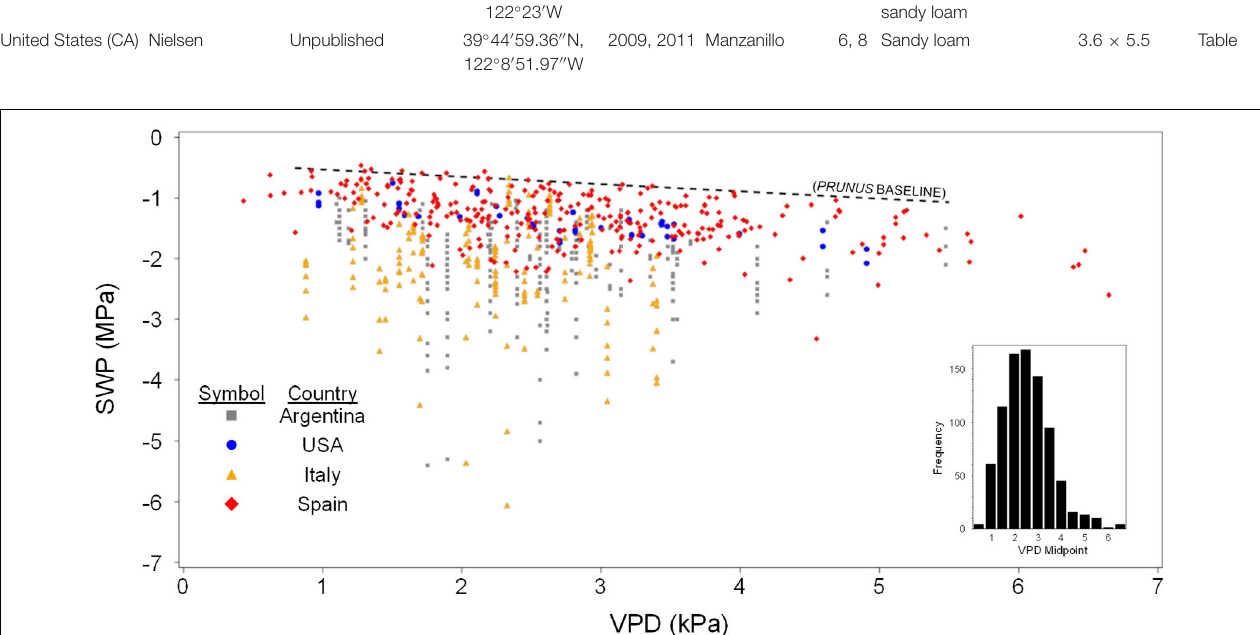
United States (CA) Haro